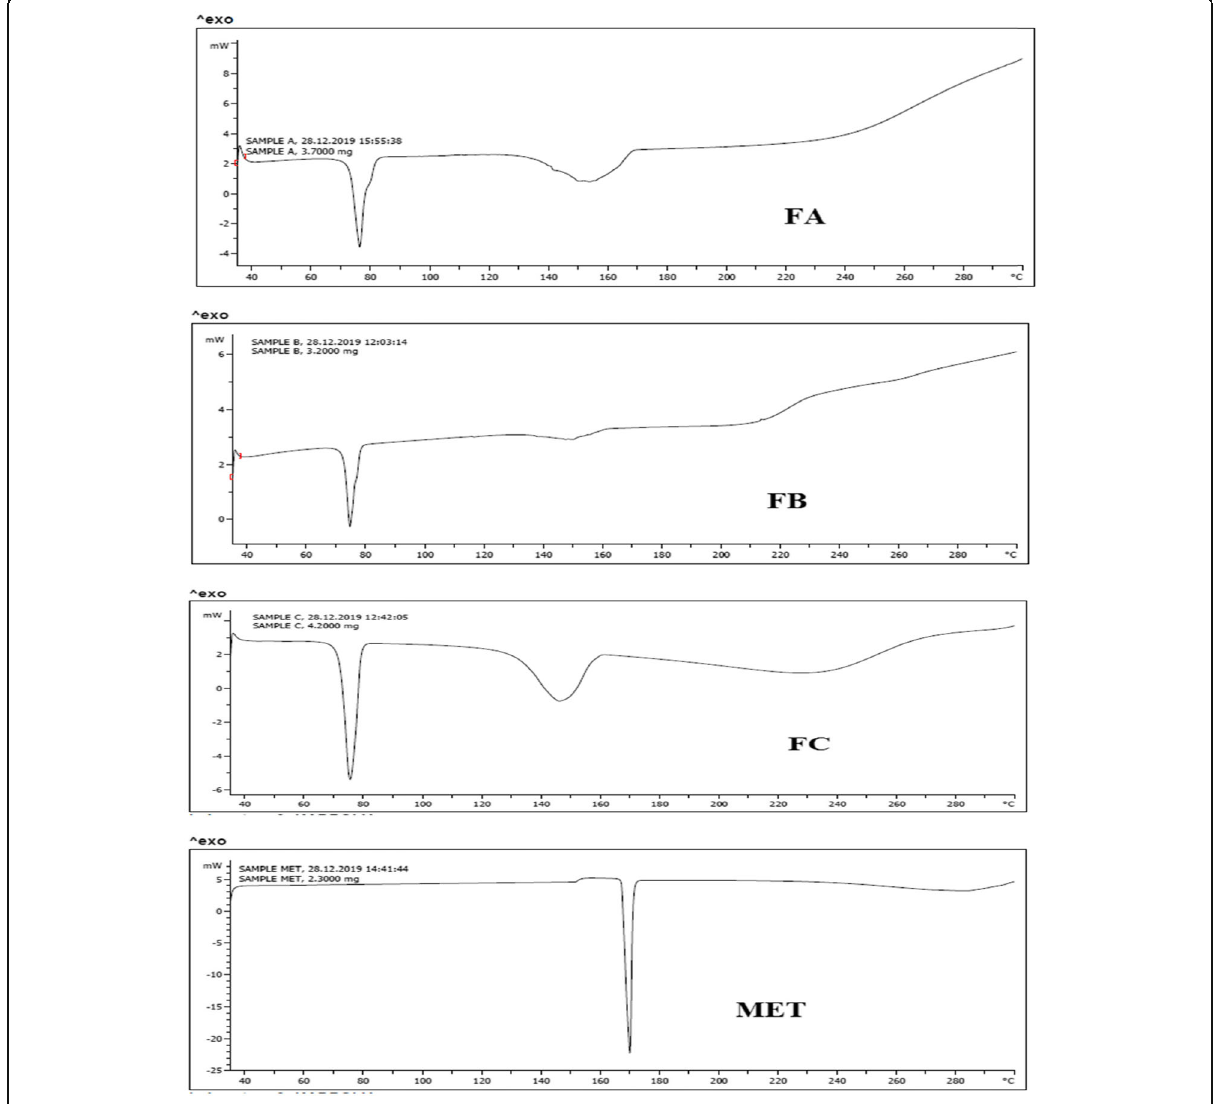
Fig. 6 Differential scanning calorimetry thermograms of pure metformin (MET) and microspheres (FA, FB, and